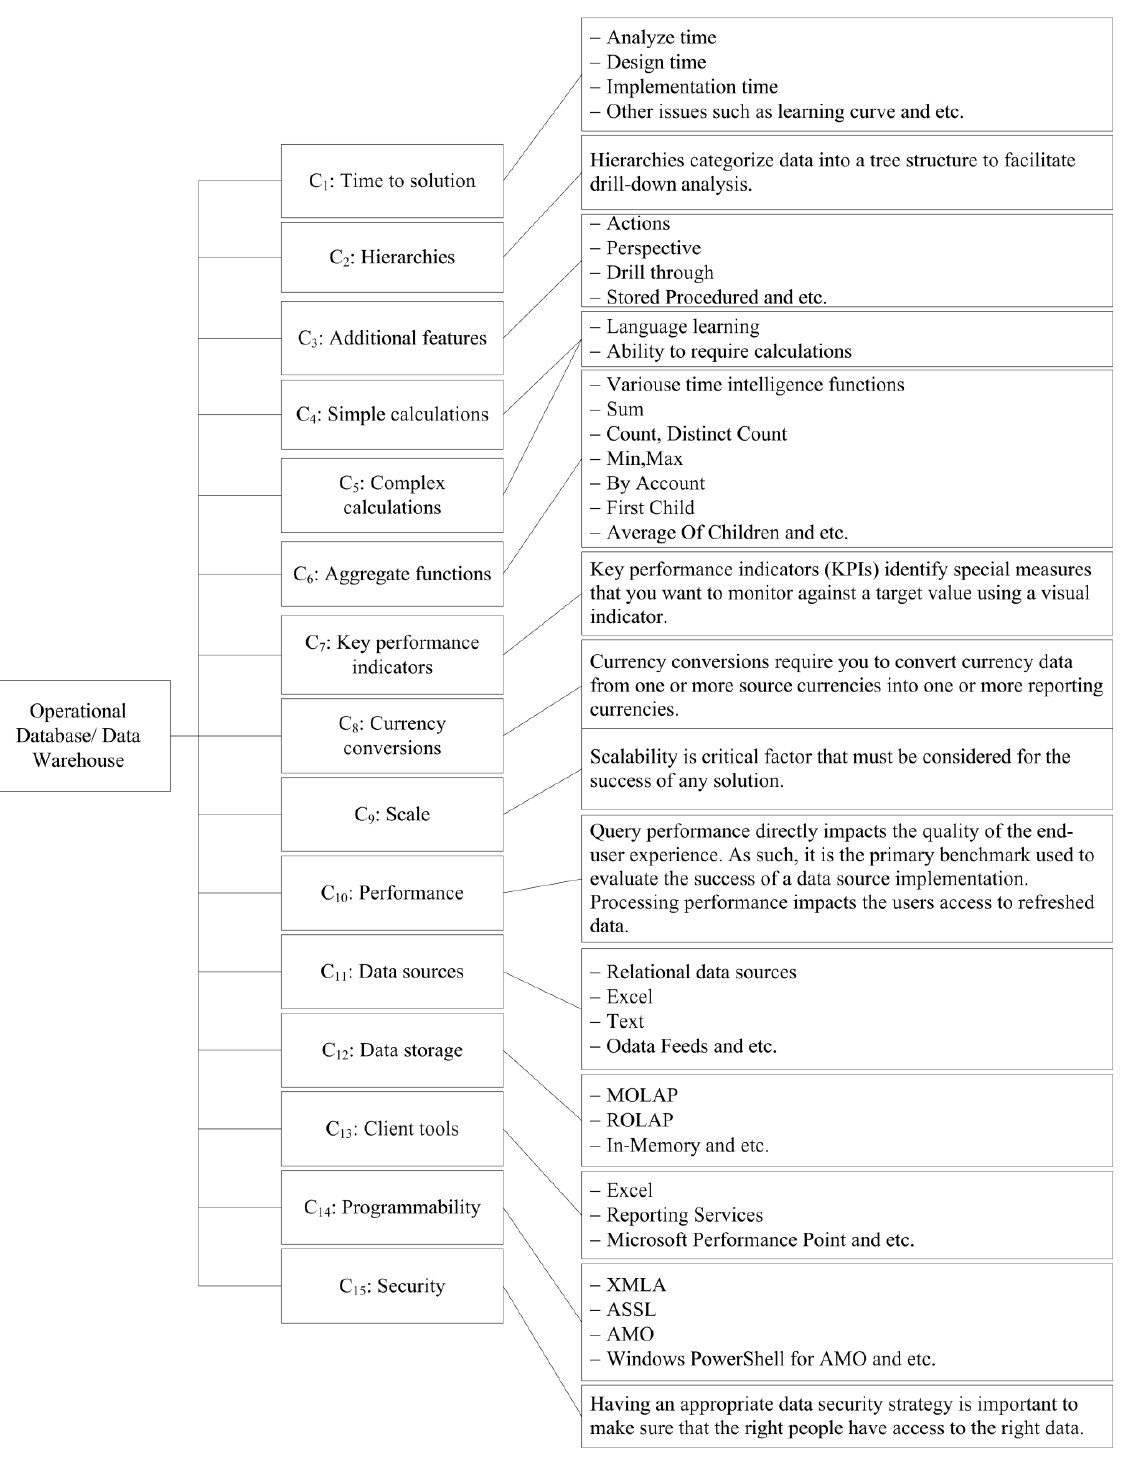
Figure 2. Criteria used for